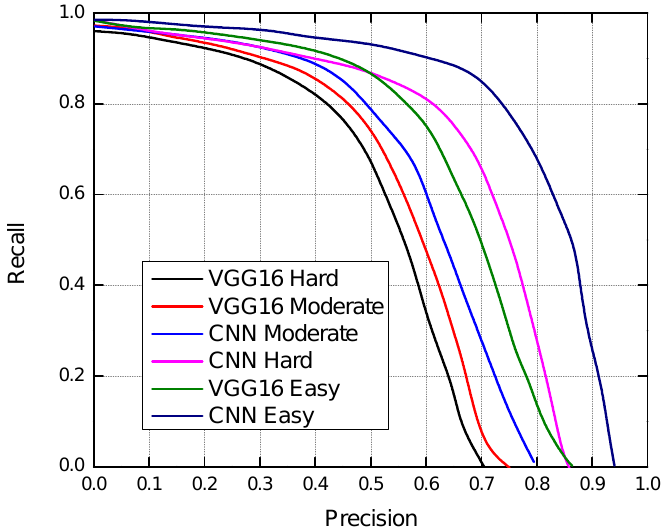
Figure 5. Three object classes with three varying degrees of complexity were examined using our CNN model, the VGG16 model, and its Precision–Recall Curve.